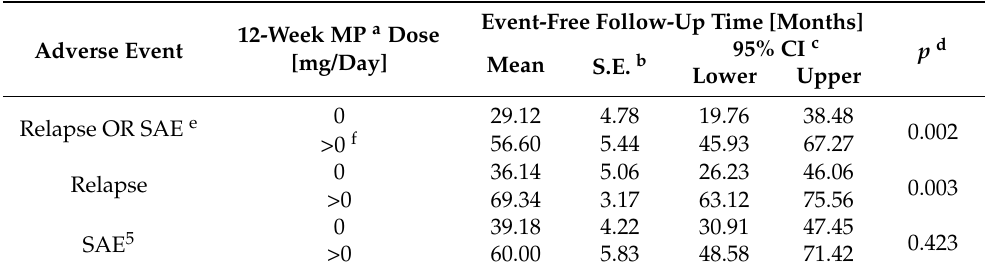
Table 7. Event-free follow-up time for the n = 44 patients with follow-up time ≥ 6 months. Compari- son between patients still taking methylprednisolone (MP) or not at week 12 of treatment.